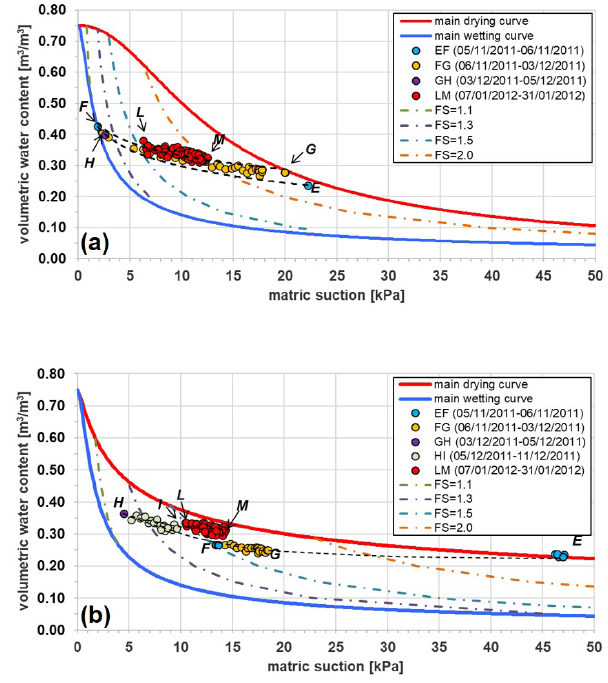
Figure 12. Volumetric water content and matric suction monitored from November 2011 to January 2012 at depths z = 0.60m (a) and z = 1.00m (b) and iso–safety factor curves. The main drying curve at z = 0.60m is obtained by fitting with Eq. (1) all the ex- perimental points monitored from 8 May to 18 July 2011 (the fit- ted parameters are shown in Table 4). The main drying curve at z = 1.00m is obtained by fitting with Eq. (1) all the experimental points monitored from 7 June to 18 July 2011 (the fitted parame- ters are shown in Table 5). The main wetting curves at both depths coincide with that derived by the infiltration tests (Damiano and Oli- vares, 2010) shown in Fig. 6. The safety factor, FS, has been calcu- lated by Eq. (2), provided by the simplified infinite slope model and assuming a homogeneous deposit with slope angle α = 40 ◦ , unit weight γ = 14kNm − 3 , cohesion c (cid:48) = 0, friction angle ϕ (cid:48) = 38 ◦ , θ s = 0 . 75m 3 m − 3 , and θ r =